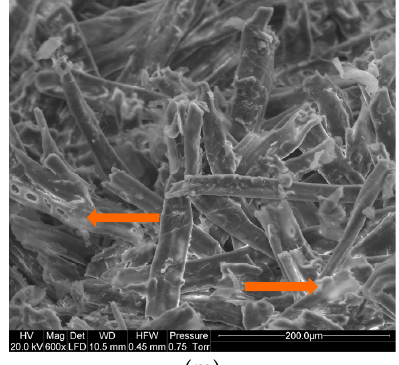
Figure 6. Scanning electron microscope images of HDF with, ( a ) DS12, ( b ) DS15, ( c ) DS20, ( d ) WS12, ( e ) WS15, ( f ) WS20, ( g ) PLA12, ( h ) PLA15, ( i ) PLA20, ( j ) PCL12, ( k ) PCL15, ( l ) PCL20, ( m ) UF12 as a binder (the arrows indicate the binder presence).